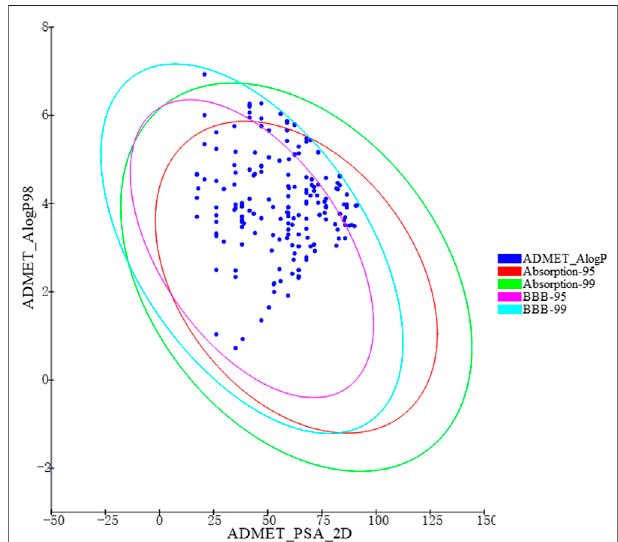
FIGURE 3 | ADMET properties diversity distribution of 226 chemical constituents. ADMET_AlogP98: lipid-water partition coef fi cient; ADMET_PSA_2D: polar molecular surface area; 2D plots of ADMET_PSA_2D and ADMET_AlogP98 show 2 series of ellipses representing the 95 and